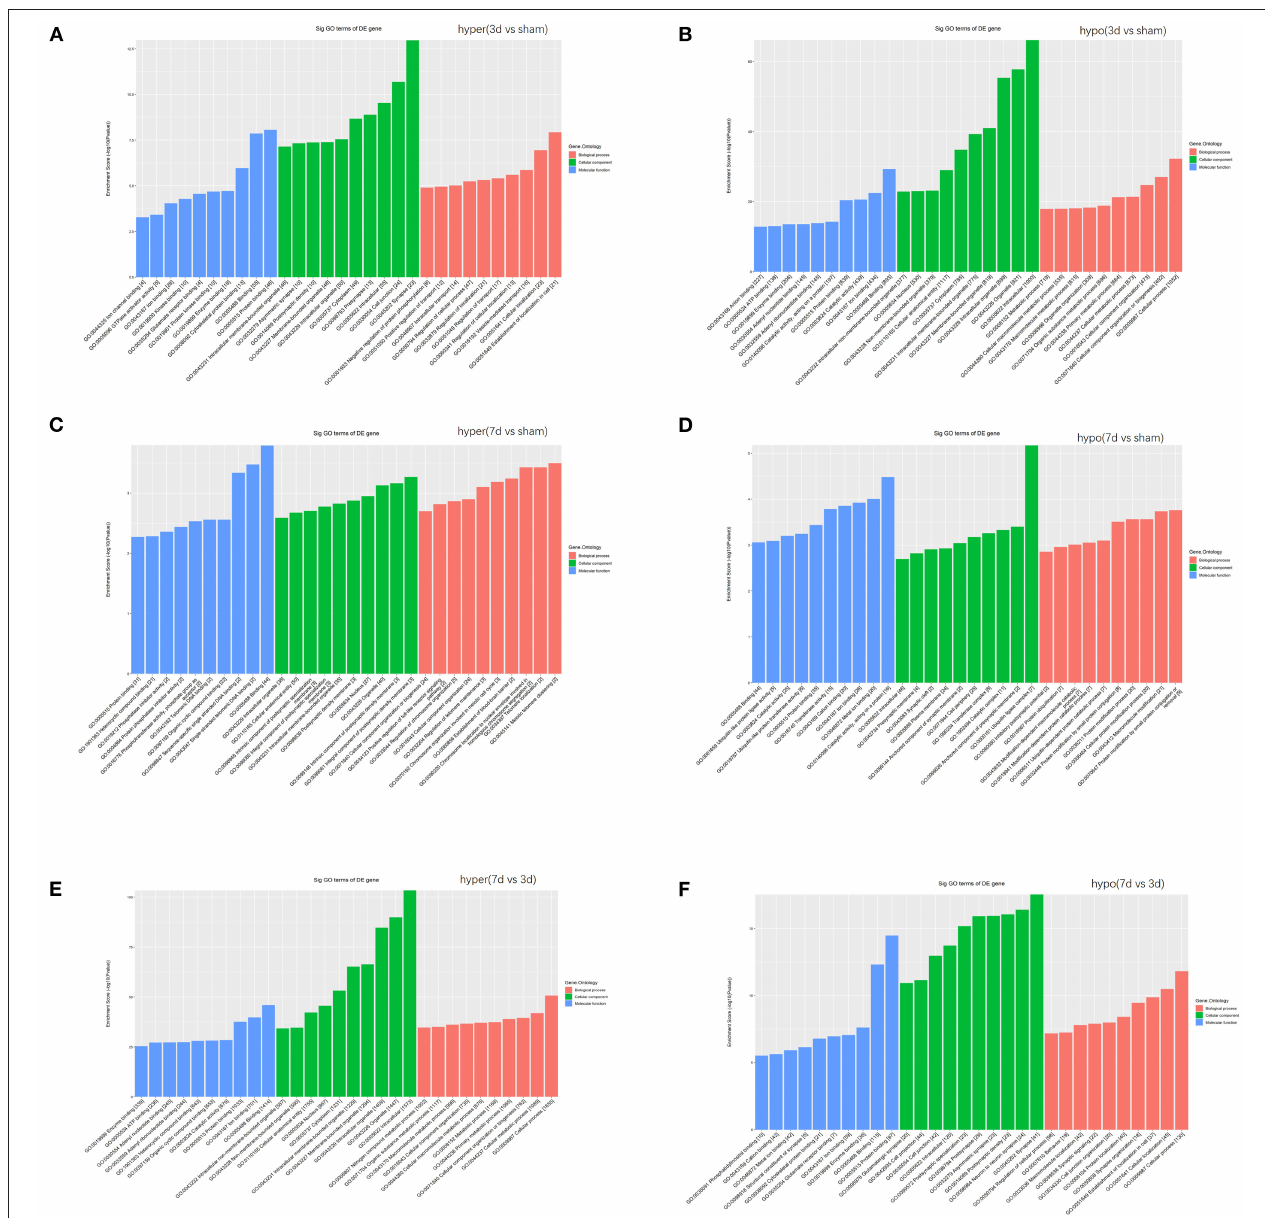
FIGURE 5 | Function analyses of the parent genes of differentially m 6 A-modified circRNAs. Function analyses of the parent genes of significantly hypermethylated and hypomethylated circRNAs around the infarct cortex in 3d vs. sham (A,B) , 7d vs. sham (C,D) , and 7d vs. 3d (E,F)